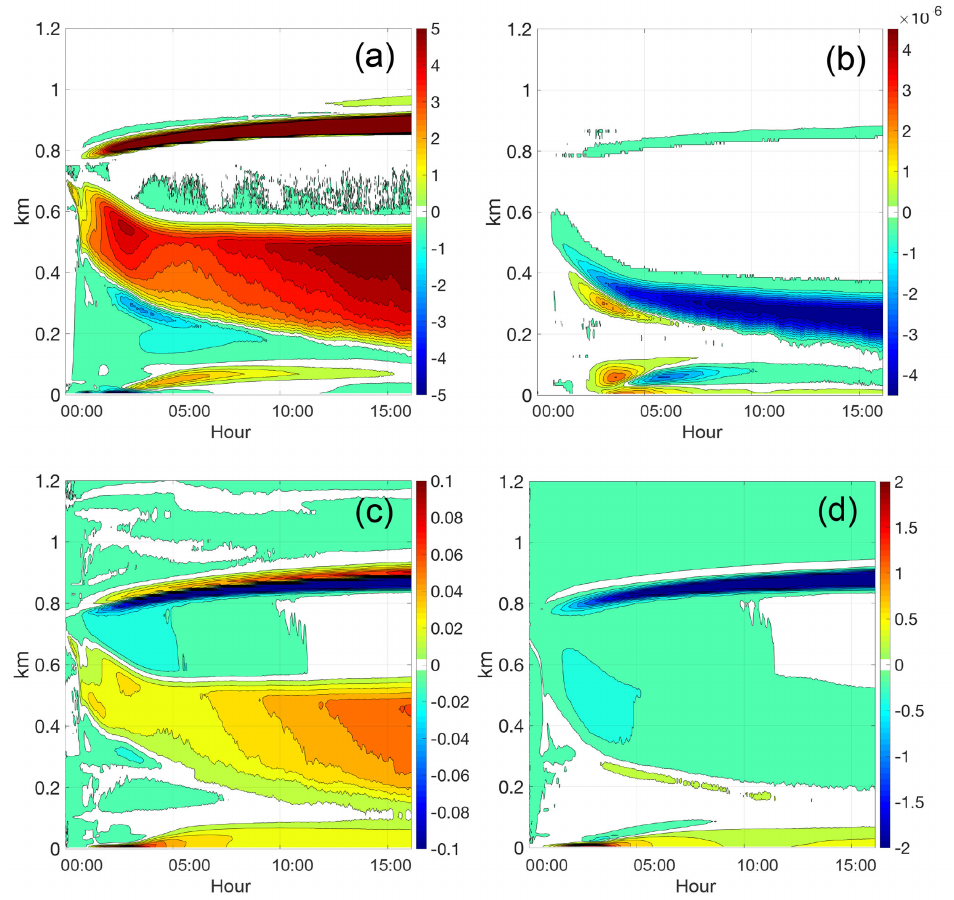
Figure 4. Impact of increasing CCN by 2 × (ConIce2.0 minus ConIce1.0) on (a) relative humidity, (b) sublimation rate, (c) water vapor mixing ratio, and (d) temperature, in units of percent, gm − 3 s − 1 , gkg − 1 , and ◦ C,